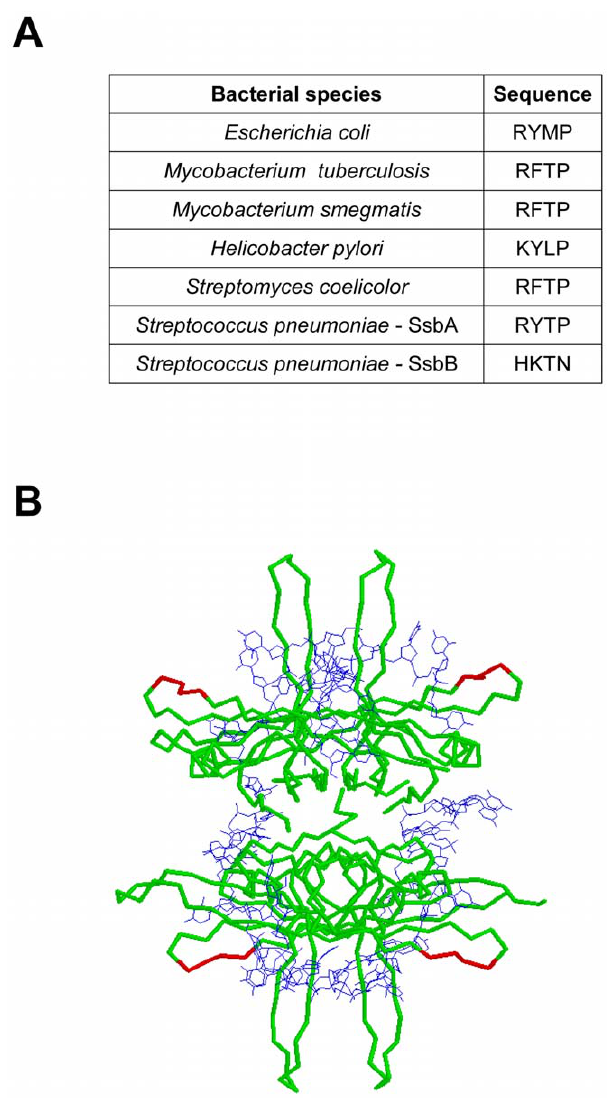
Figure 11. Loop 1 region of bacterial SSB proteins. A, Comparison of sequences from the Loop 1 region of the SSB proteins from Escherichia coli (PDB code 1eyg), Mycobacterium tuberculosis (PDB code 1ue1), Mycobacterium smegmatis (PDB code 1x3e), Helicobacter pylori (PDB code 2vw9), and Streptomyces coelicolor (PDB code 3eiv) with the corresponding sequences from the Streptococcus pneumoniae SsbA and SsbB proteins. B, Structural model for an SsbEc tetramer ( green )-single-stranded DNA ( blue ) complex (based on PDB code 1eyg) [7]. The RYMP sequence in the Loop 1 region of each SsbEc subunit is highlighted ( red ).